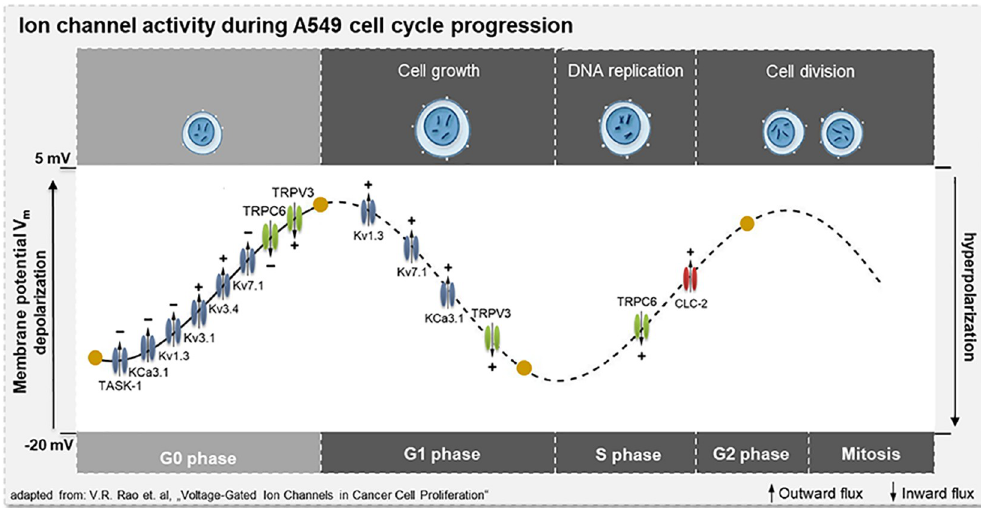
Fig 6. Schematic illustration of the simulated ion channel activity during the A549 cell cycle. G0/G1 transition: modulation of ion channel activity predicted by the model approach. G1/S and S/G2 transition: simulation of ion channel activation and inactivation, responsible for A549 cell cycle progression. Calculated membrane potentials for G0, G1, S and G2 phase are illustrated by yellow dots: V m_G0 = -10.4 mV, V m_G1 = -1.33 mV, V m_S = -13.3 mV, V m_G2/M = -5.49 mV. The symbols + and − indicate activation and inactivation of ion channels.